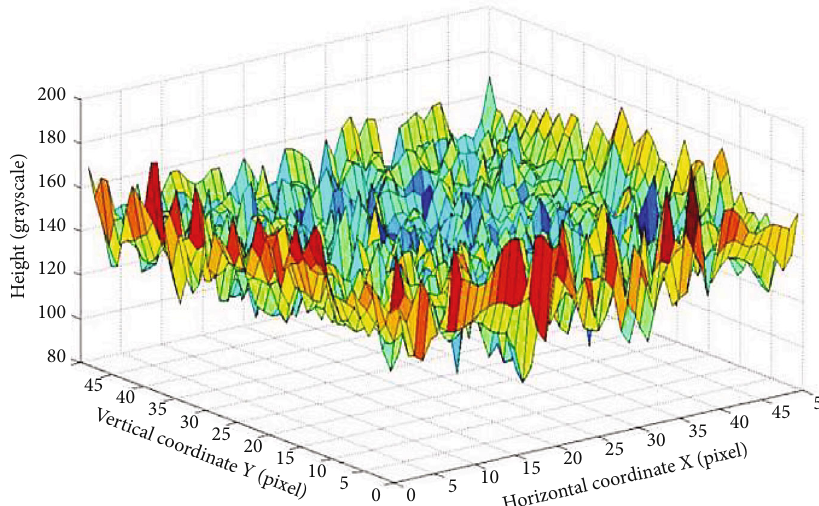
Figure 5: 3D surface of asphalt pavement surface image.